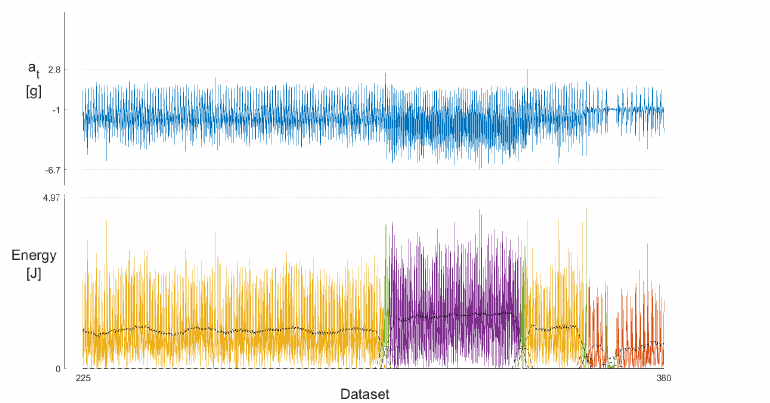
Figure 5. The top y-axis shows the accelerometer data track, where higher accelerations can be seen during canter (purple) than during walking (orange) and trot (yellow). The bottom uses the same time scale, shows the amount of motion (colorized for the different gaits) and the general trend (black line) for the amount of motion. The amount of motion during canter is higher than during trot, walking and stand.